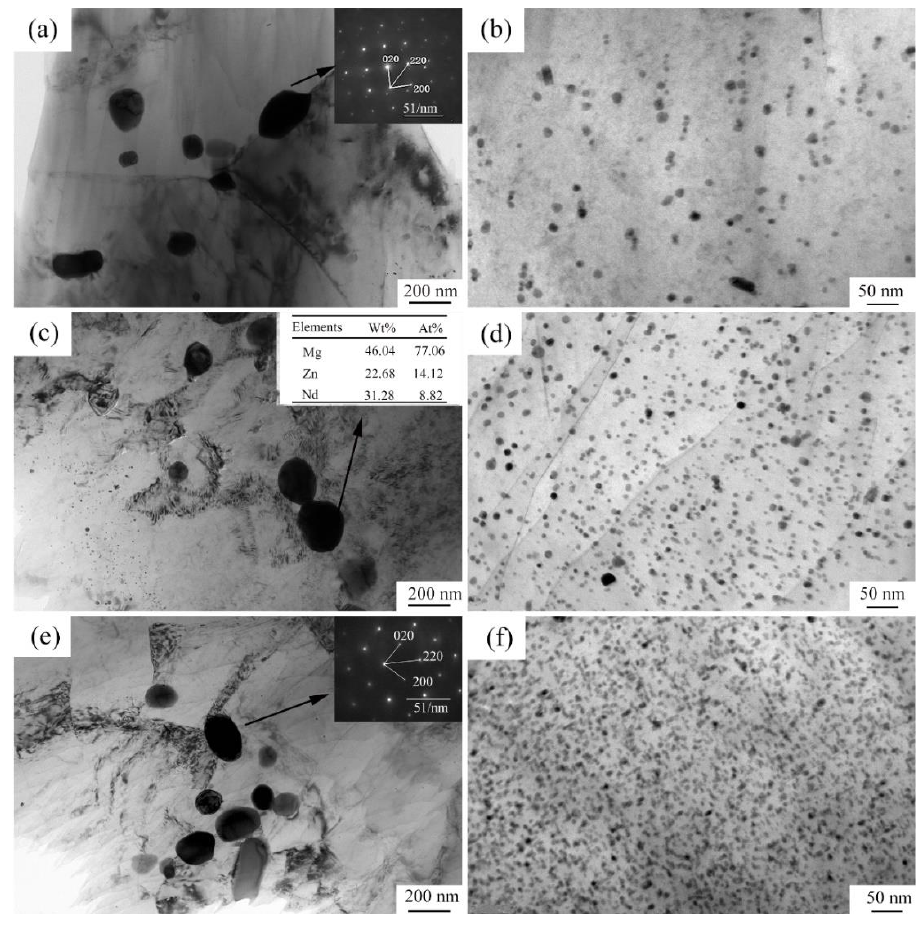
Figure 5. TEM images of the four-pass extruded alloys: ( a , b ) Mg-2Zn-0.5Gd-0.5Zr alloy; ( c , d ) Mg- 2Zn-0.5Nd-0.5Zr alloy; ( e , f ) Mg-2Zn-0.5Y-0.5Zr alloy.